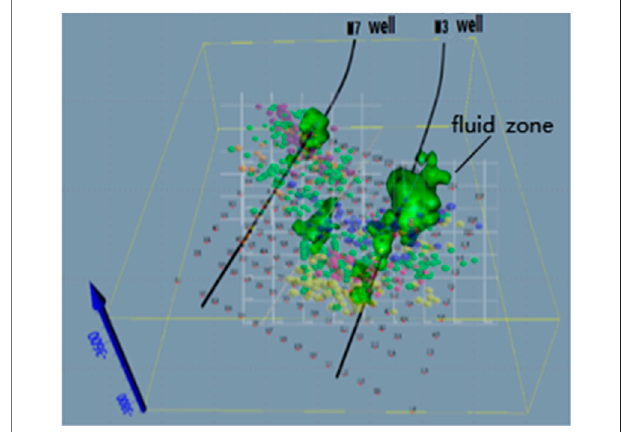
FIGURE 13 | Stereo contrast of microseismic and electromagnetic